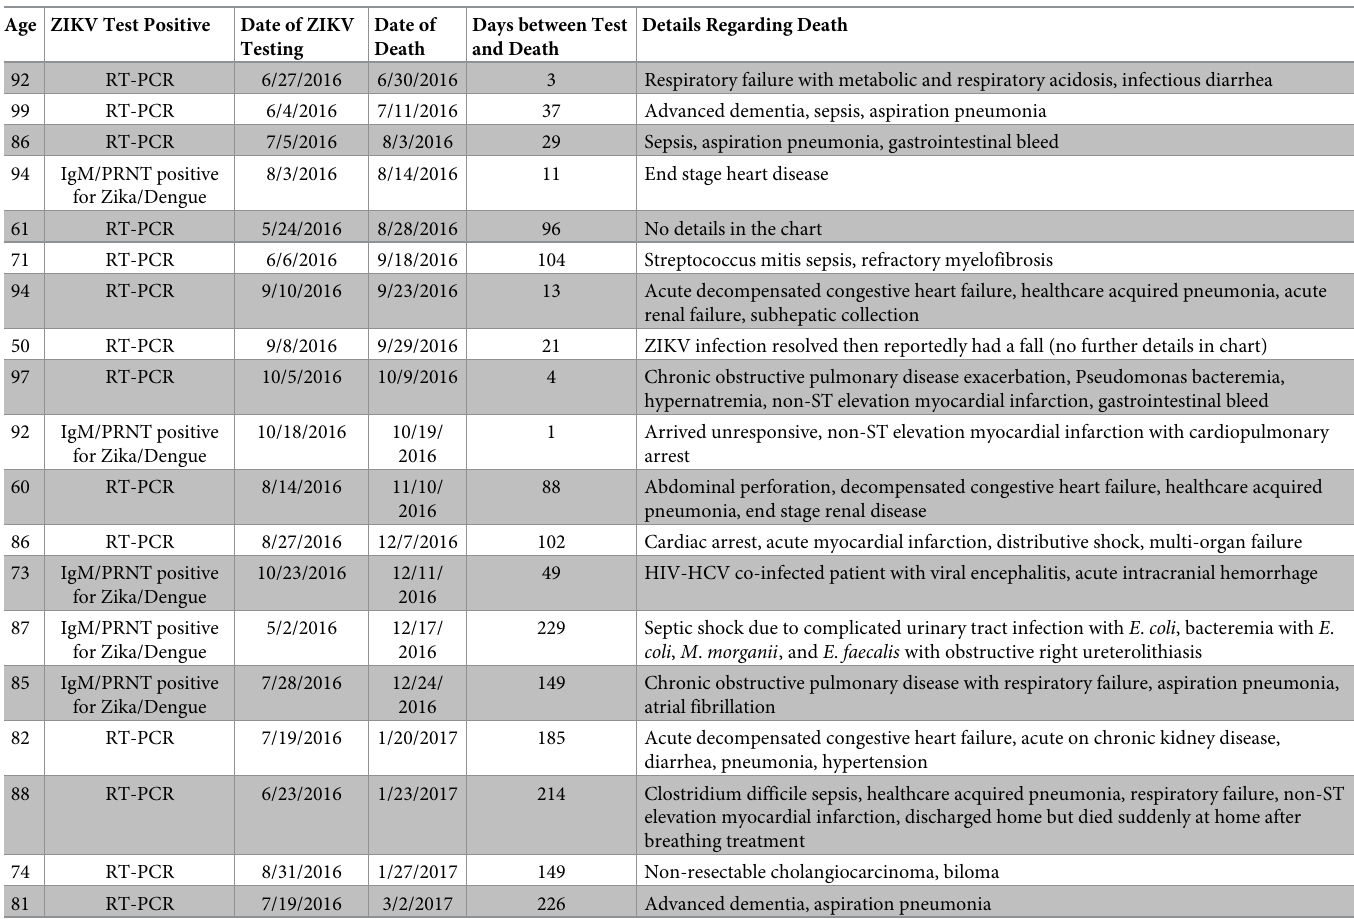
Table 5. Post-ZIKV infection deaths—Veterans affairs caribbean healthcare system,